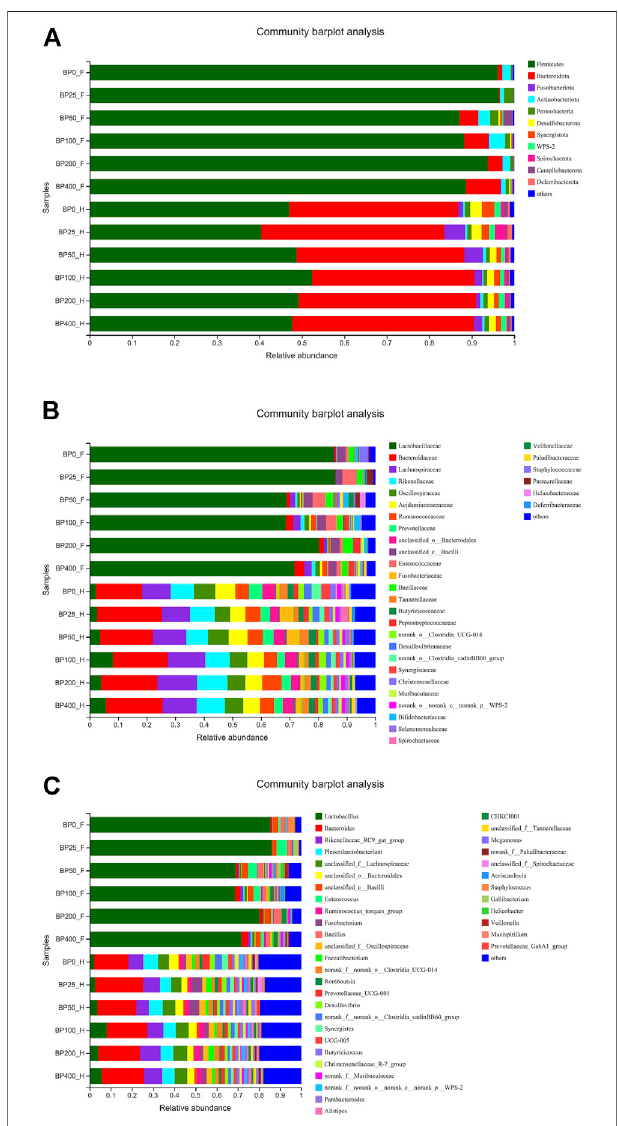
FIGURE 6 | (A) The community barplot analysis of intestinal microbiota at phylum level. (B) The community barplot analysis of intestinal microbiota at family level. (C) The community barplot analysis of intestinal microbiota at genus level.